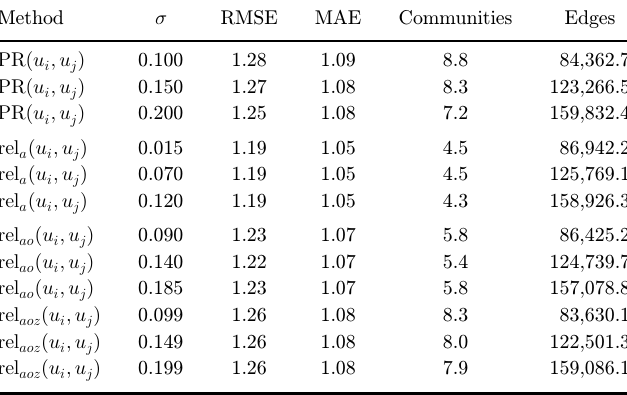
Table 1. Summary of results obtained by di®erent combinations of de- mographic user attributes that were used to create the social graph. Each entry represents the average of 10 algorithm